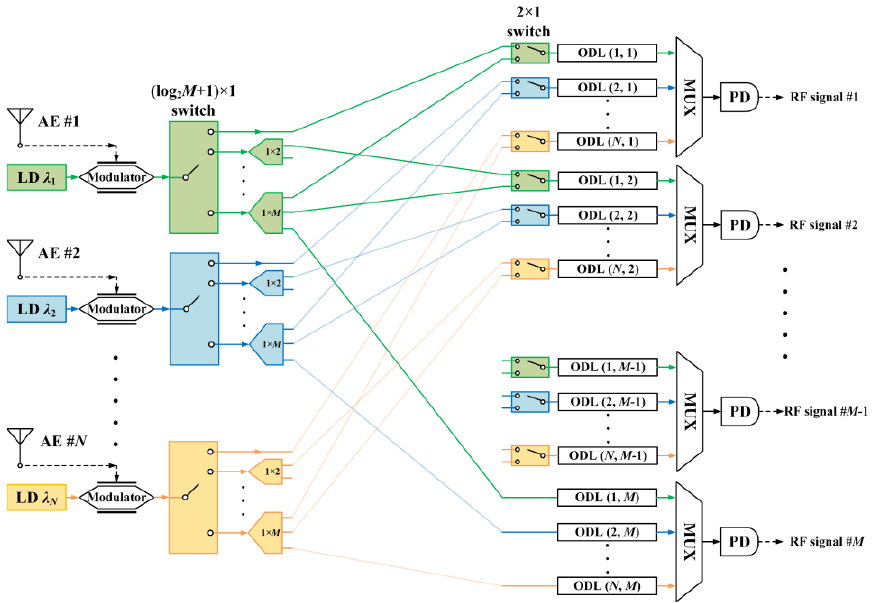
Figure 3. Illustration of structure equal-precedence.